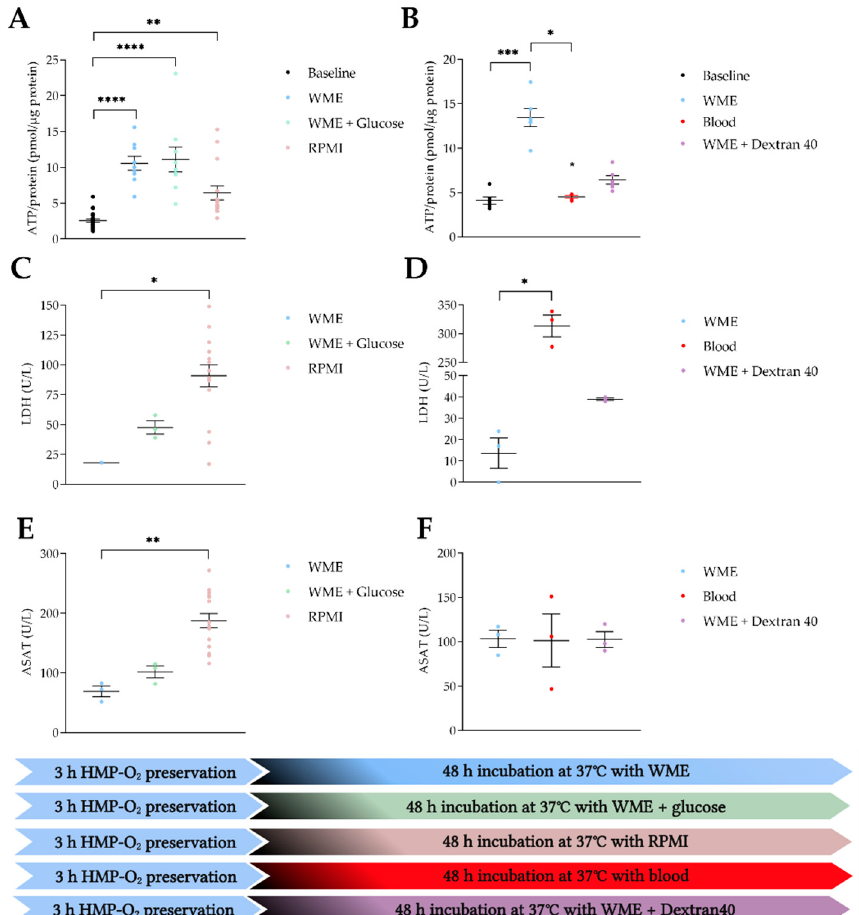
Figure 4. Viability and injury markers after 48 h of incubation using different medium compositions. ( A , C , E ) HMP-O 2 with UW-CS at baseline ( ● ) ( n = 24) and incubation with WME ( ● ) ( n = 9), WME with glucose ( ● ) ( n = 9), and RPMI ( ● ) ( n = 14). ( B , D , F ) HMP-O 2 with UW-MP at baseline ( ● ) ( n = 6) and incubation with WME ( ● ) ( n = 6), blood ( ● ) ( n = 5), and WME with Dextran40 ( ● ) ( n = 6). ( A ) ATP/protein levels after incubation with different media. ( B ) ATP/protein levels after incubation with different media. ( C ) Cumulative LDH levels after incubation with different media. ( D ) Cumulative LDH levels after incubation with different media. ( E ) Cumulative ASAT levels after incubation with different media. ( F ) Cumulative ASAT levels after incubation with different media.